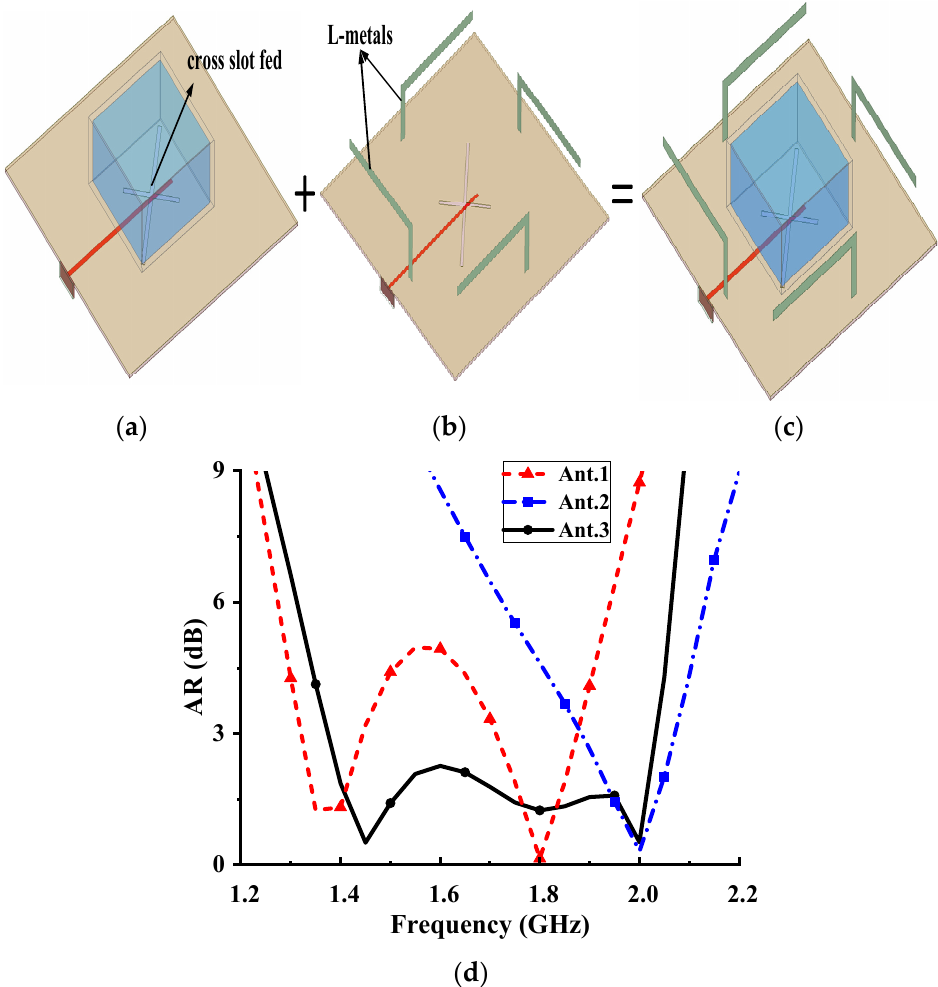
Figure 2. Configurations of the reference antennas. ( a ) Ant. 1. ( b ) Ant. 2. ( c ) Ant. 3. ( d ) ARs.